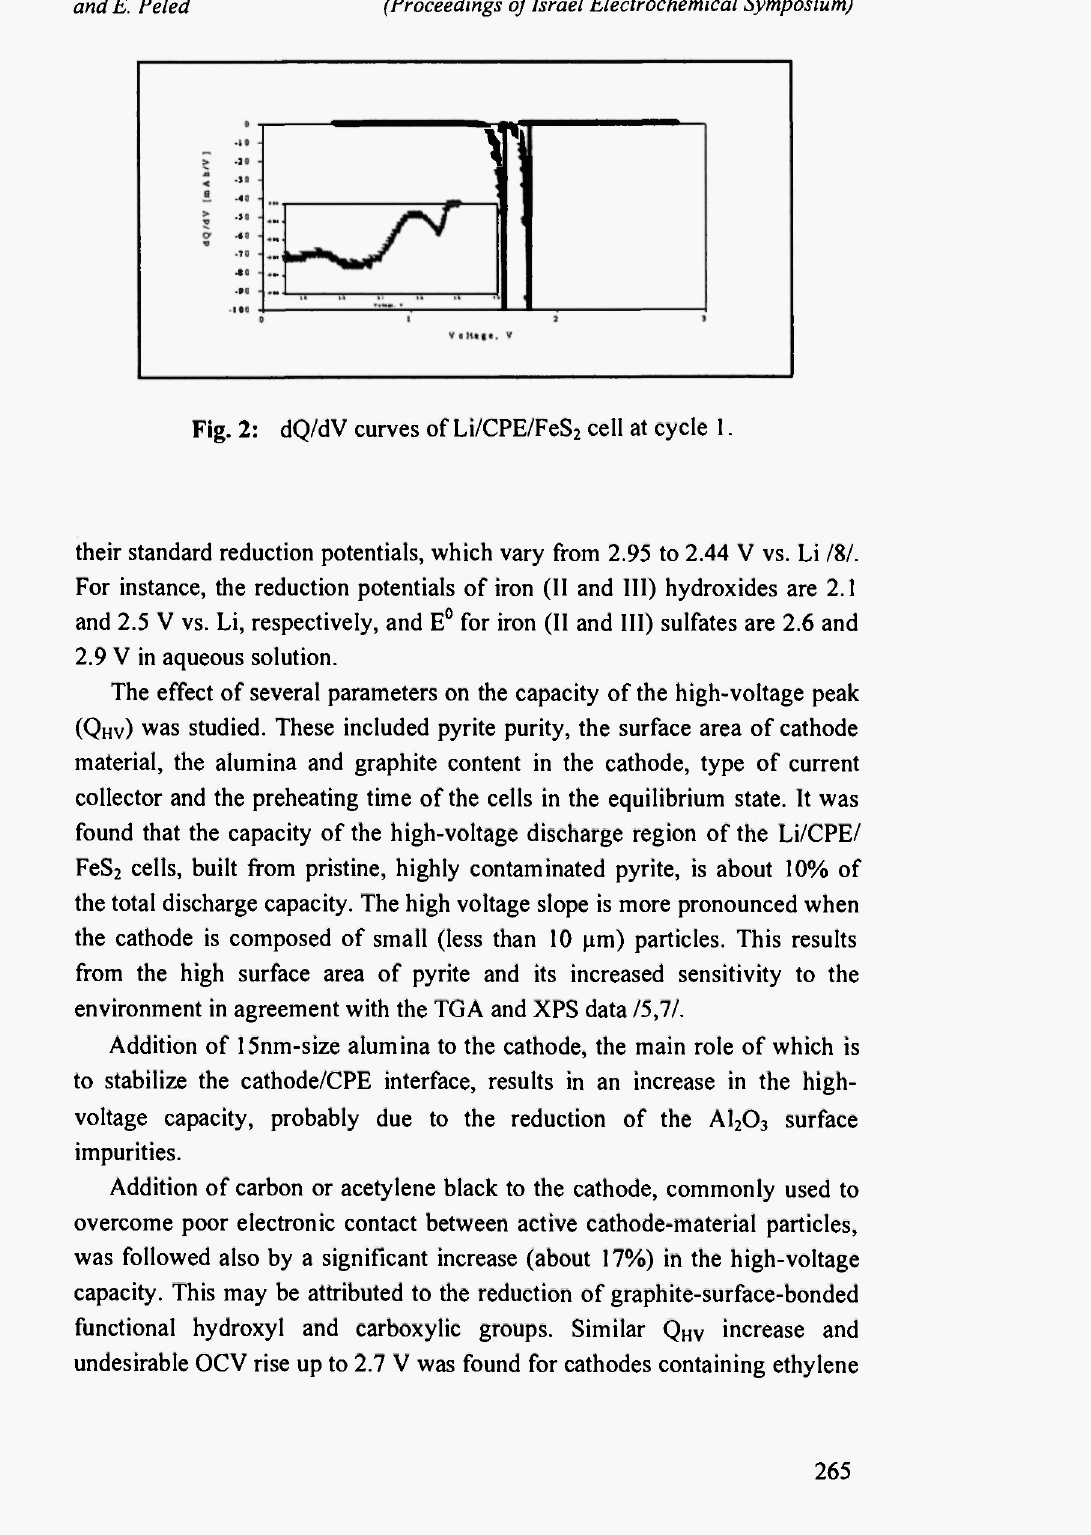
Fig. 2: dQ/dV curves of Li/CPE/FeS 2 cell at cycle 1 .